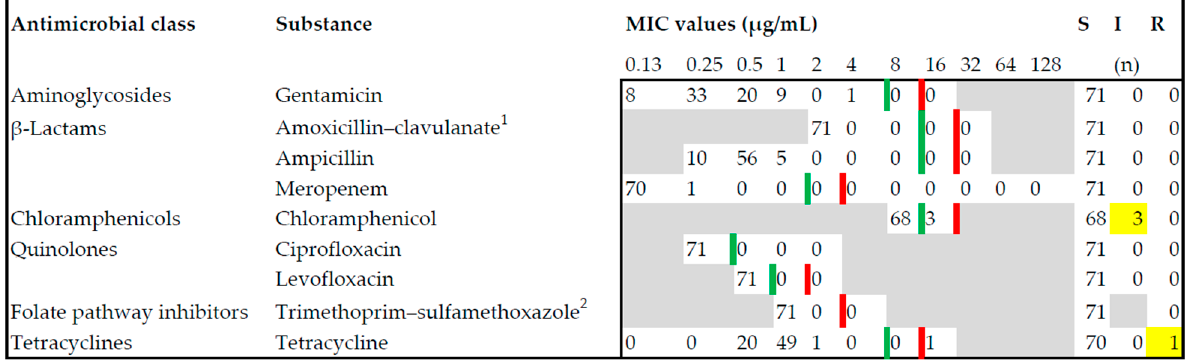
Figure 1. Antimicrobial susceptibility testing for Salmonella Dublin isolated from bovines, pigs, and dogs was carried out on nine substances from six antimicrobial classes. Red lines delineate the breakpoints towards resistant (R), and green lines delineate the breakpoints towards intermediate (I) minimum inhibitory concentration (MIC). Yellow boxes indicate the only intermediate and resistant isolates found in this study. Most of the isolates were completely susceptible (S). 1 Concentration of amoxicillin is reflected, concentration ratio of amoxicillin–clavulanate: 2:1. 2 Concentration of trime- thoprim is reflected, concentration ratio of trimethoprim–sulfamethoxazole: